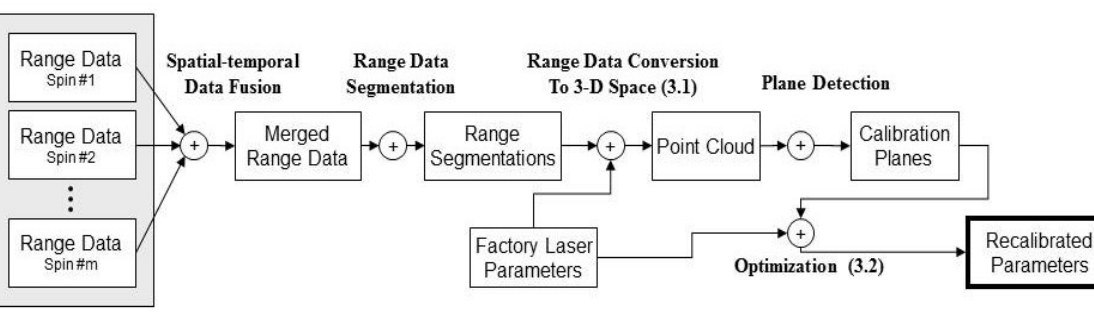
Figure 2. Process of the proposed automatic on-site recalibration